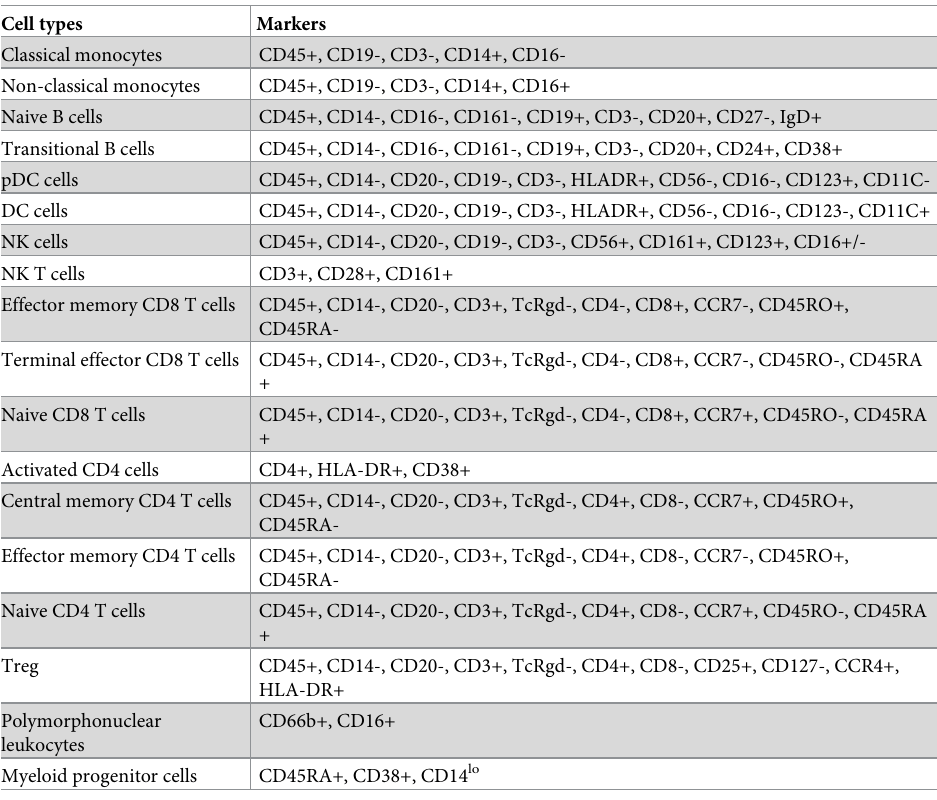
Table 2. Human CyTOF